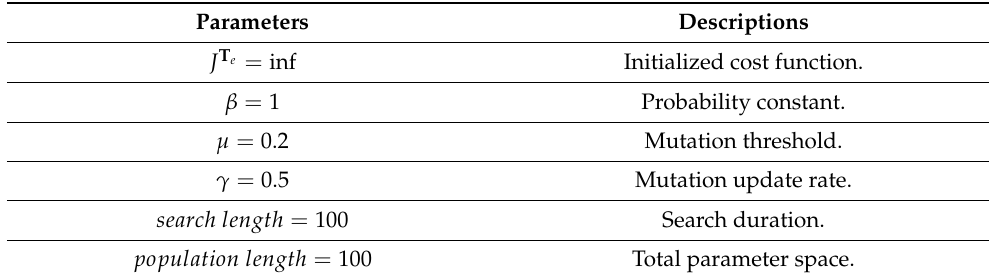
Table 1 specifies the parameters of the genetic algorithm. Table 1. Parameters of the genetic